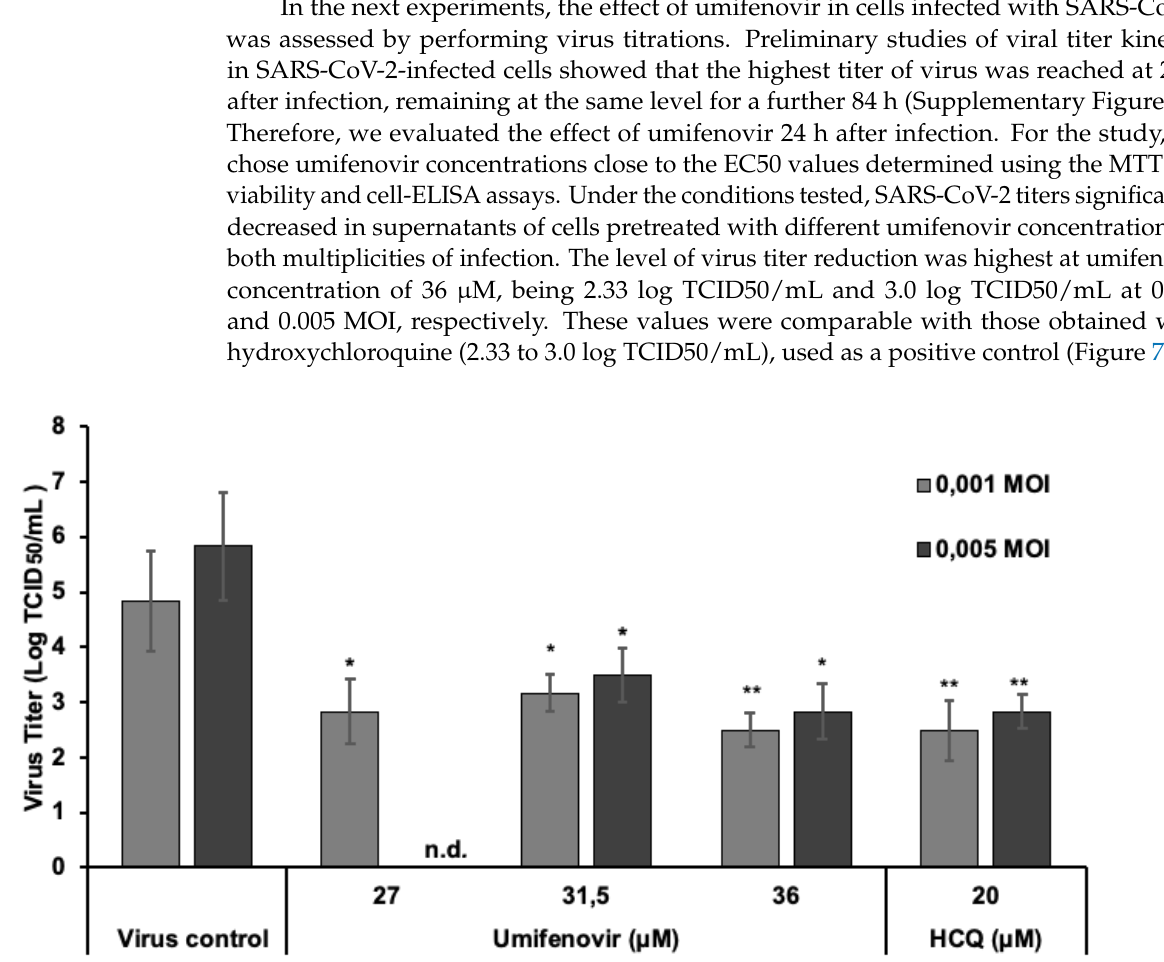
Figure 7. Effect of umifenovir and hydroxychloroquine (HCQ) on viral titers in SARS-CoV-2-infected Vero CCL81 cells at low and high multiplicities of infection. Vero CCL81 cells were pre-treated with drugs for 2 h, and virus at doses of 0.001 and 0.005 MOI was then added. After incubation or 24 h, the culture supernatants were collected to quantify viral loads by titration using the tissue culture infectious dose 50 (TCID50) method. The viral titers (log TCID50/mL) are shown as mean ± SD. Data represent three independent experiments. Differences between virus control group and treated groups: * p < 0.05, ** p < 0.01. Kruskal–Wallis test. n.d.—not determined.